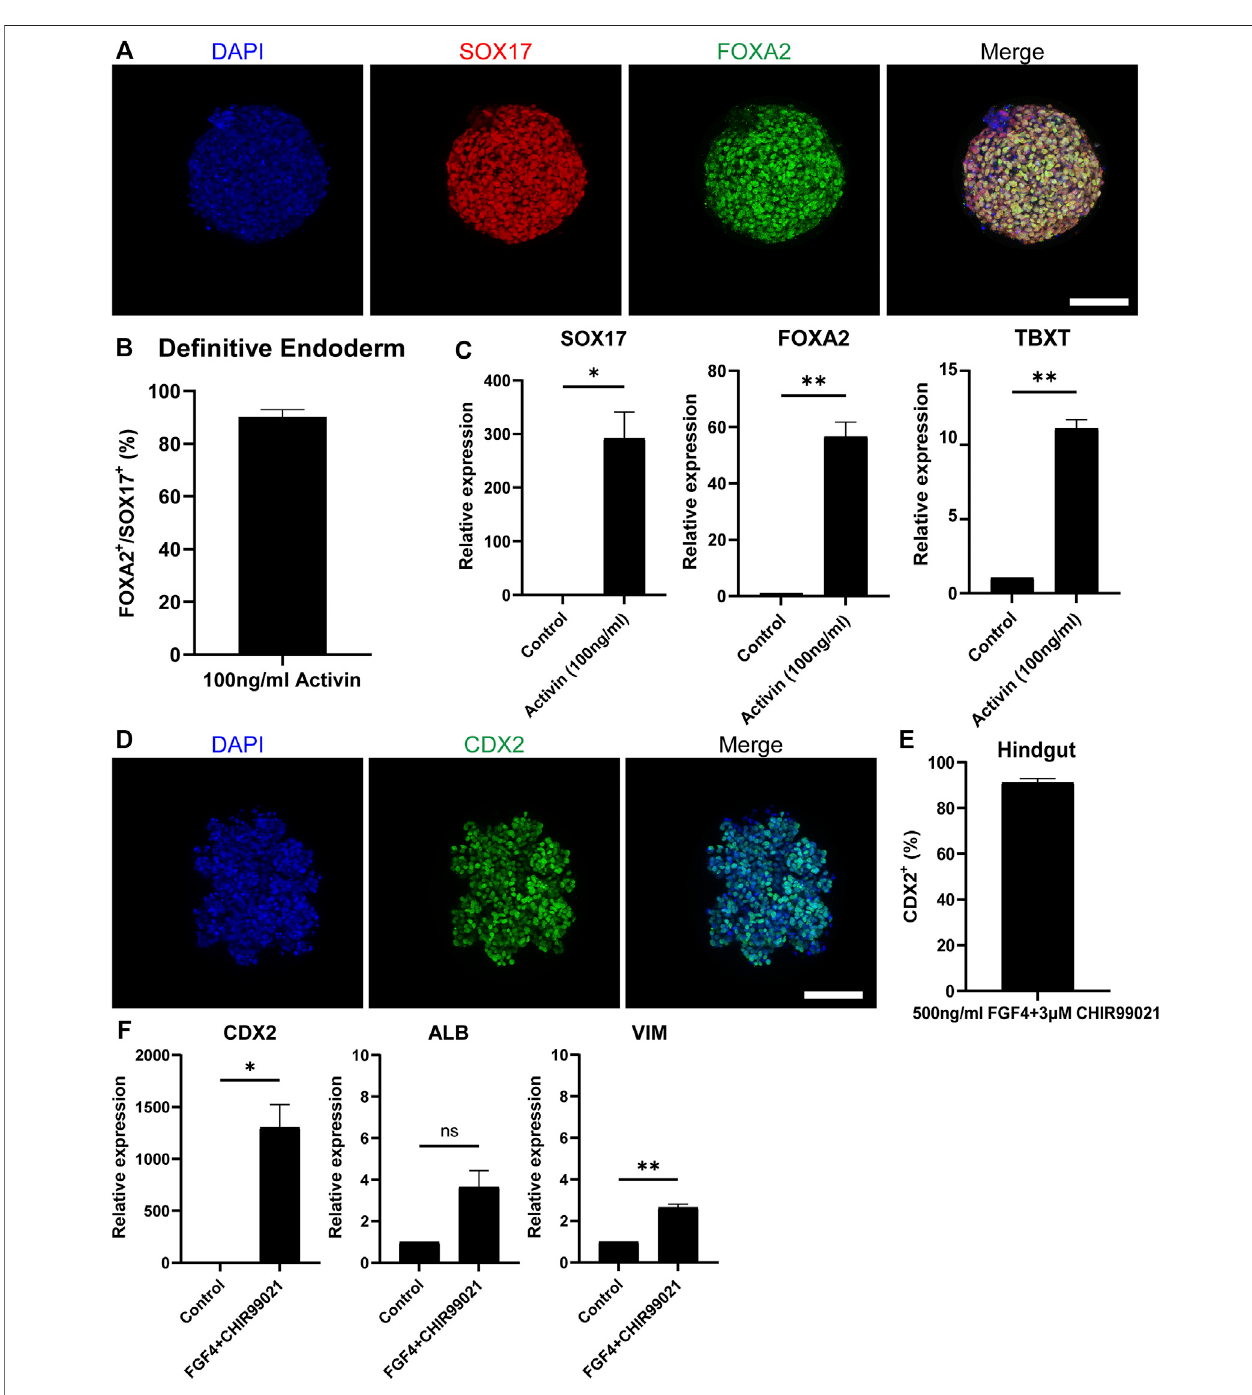
FIGURE2| Differentiationtowardsde fi nitiveendodermfollowedbyhindgutspeci fi cation. (A) H9-derivedEBsweretreatedwith100 ng/mlActivinandtheresulting spheroids were stained with the DE markers: SOX17 (red) and FOXA2 (green) and counterstained with DAPI (blue). Scale bar: 100 μ m. (B) Quanti fi cation of the fl uorescent images showed that about 92% of the cells in Activin-treated EBs are co-expressing SOX17 and FOXA2. (C) qRT-PCR showed signi fi cantly increased expression of the DE genes SOX17 and FOXA2 and the mesoderm marker TBXT but in lower amounts. (D) DE spheroids were further treated with FGF4 and CHIR99021toinduce hindgutspeci fi cation. After4 daysoftreatment, thespheroids werestainedforthehindgutmarkerCDX2. Scale bar:100 μ m. (E) Quanti fi cationof the fl uorescent images showed that about 90% of the cells were CDX2 + . (F) qRT-PCR con fi rmed the robust expression of CDX2 , whereas there was no signi fi cant expression of the foregut marker ALB . Low levels of the mesenchymal marker VIM were also detected. Error bars indicate mean ± S.E.M. ( n = 3).